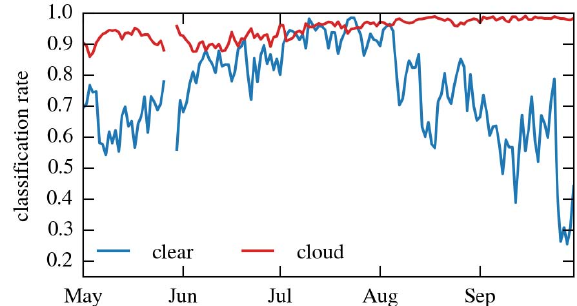
Figure 6. Time series of daily mean classification rates for 2009. As an example, a value of 0.9 for cloud means that 90% of the cloud pixels in the AATSR mask are correctly classified as cloud-covered and the remaining 10% are missed clouds.